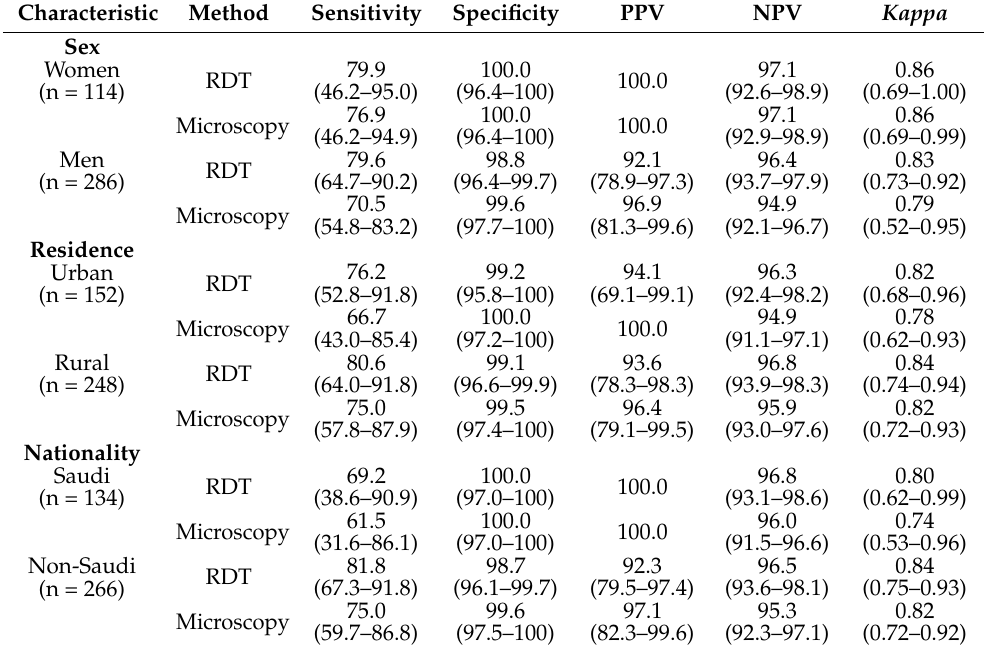
Table 4. Performance according to participants’ characteristics of RDT and light microscopy tech- niques in the diagnosis of falciparum malaria against PCR as reference